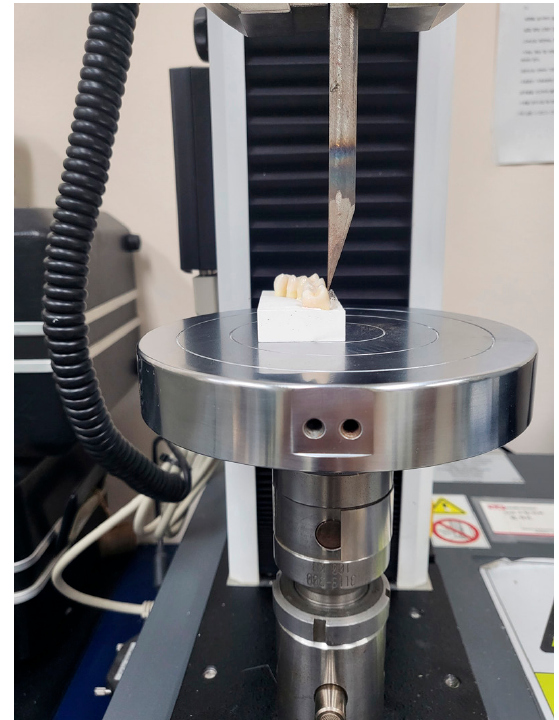
Figure 3. Shear bond strength